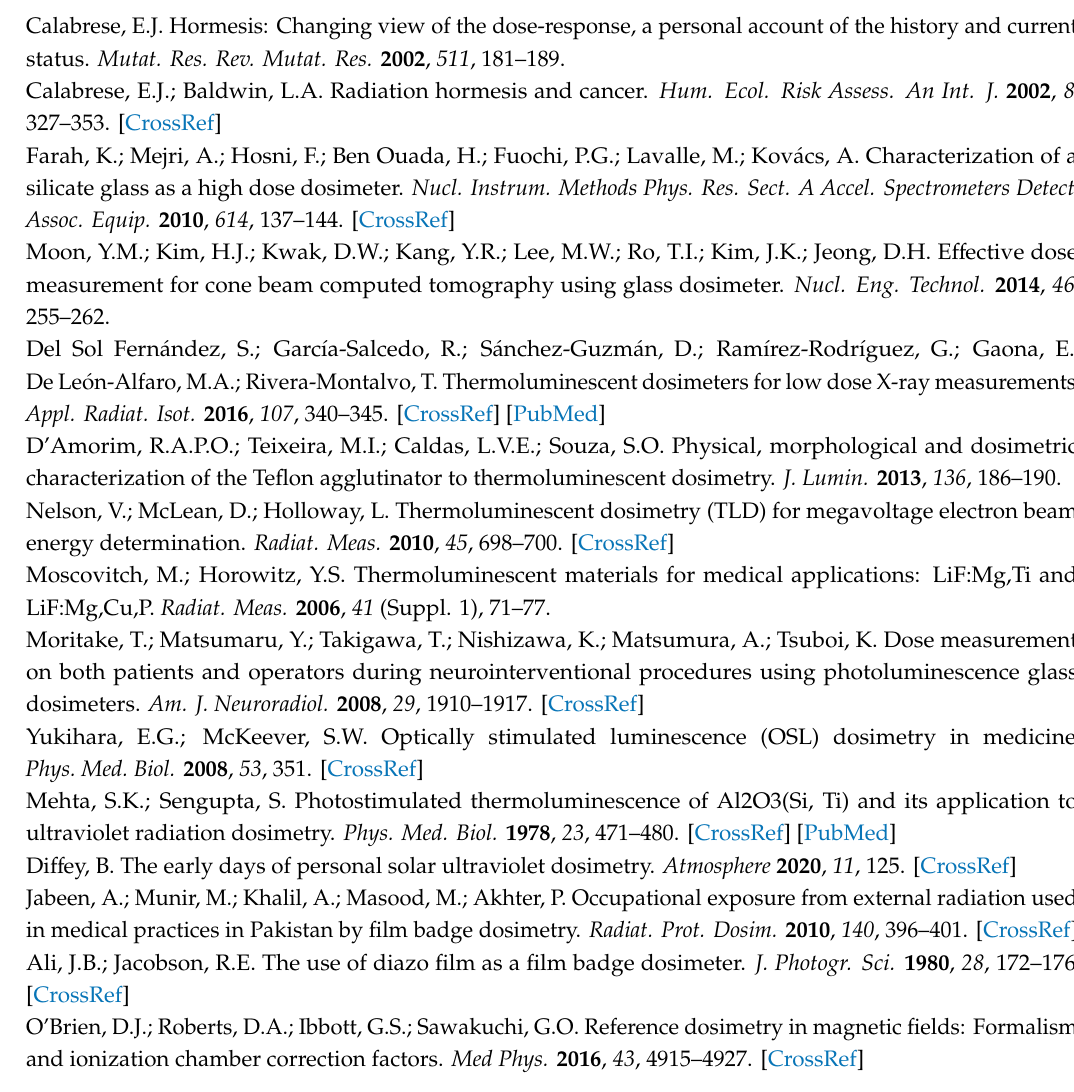
Figure S1: Absorbance spectra of the Fricke dosimeter before and after X-ray exposure. Figure S2: ATR-FTIR spectra of the composite fibers, MBTT (photoacid), leuco dye Black 305, and PS fibers. Figure S3: TGA thermograms of the fibrous color dosimeter with a MBTT / Black305 ratio at 3.0 / 3.0 w / w , Black305, MBTT, and PS fibers in air. Figure S4: Dose-response curves of the fibrous color dosimeters made of the composite fibers consist of MBTT / Balck305 3.0 / 3.0 by weight at di ff erent temperatures (a) 20 ◦ C, (b) 40 ◦ C, (c) 60 ◦ C. The color bar signifies the color tone corresponding to ∆ E . The black broken line indicates the point at which color change can be visually